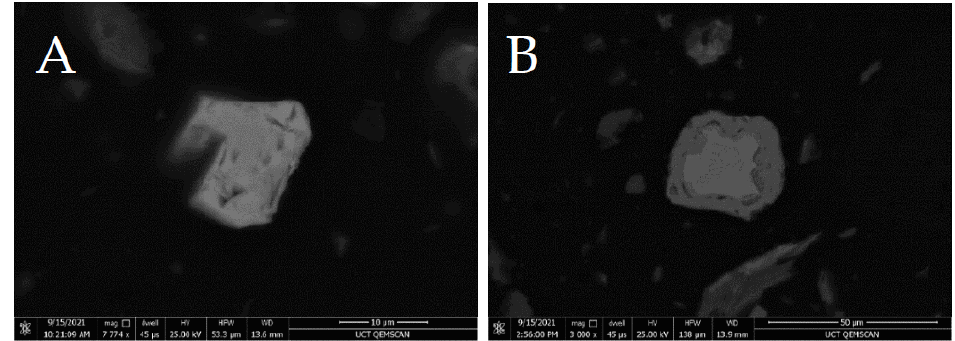
Figure 4. ( A ) Arsenopyrite in Sample 1. ( B ) Pyrite surrounded by iron oxide layer in Sample 3.